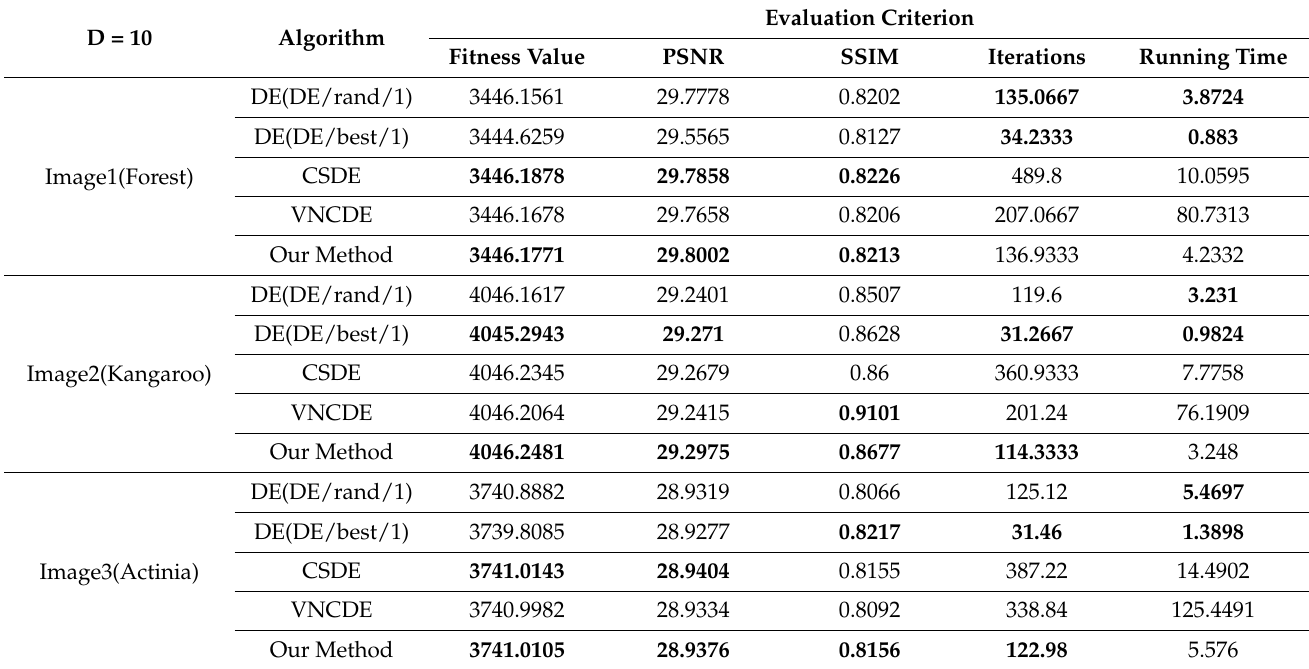
Table 6. Results comparison of five algorithms for segmentation of images 4–6 on different criteria when D =